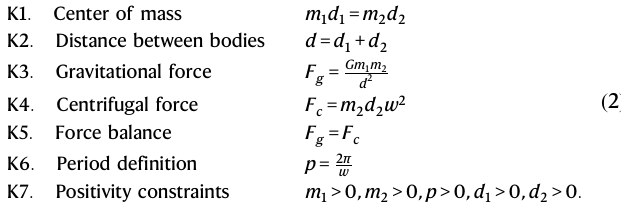
present system generates hypotheses from data using symbolic regression, which are posed as conjectures to an automated deductive reasoning system, which proves or disproves them based on background theory or provides reasoning- based quality